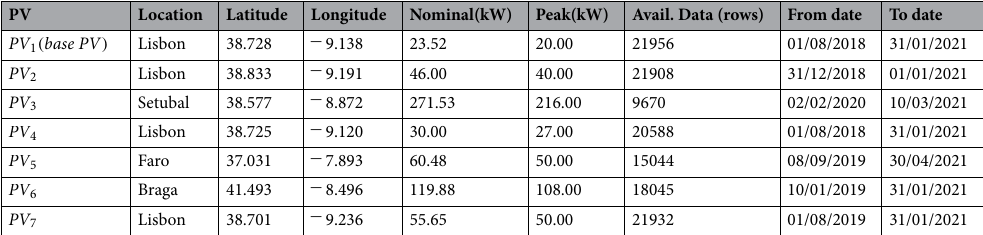
PV Location Latitude Longitude Nominal(kW) Peak(kW) Avail. Data (rows) From date